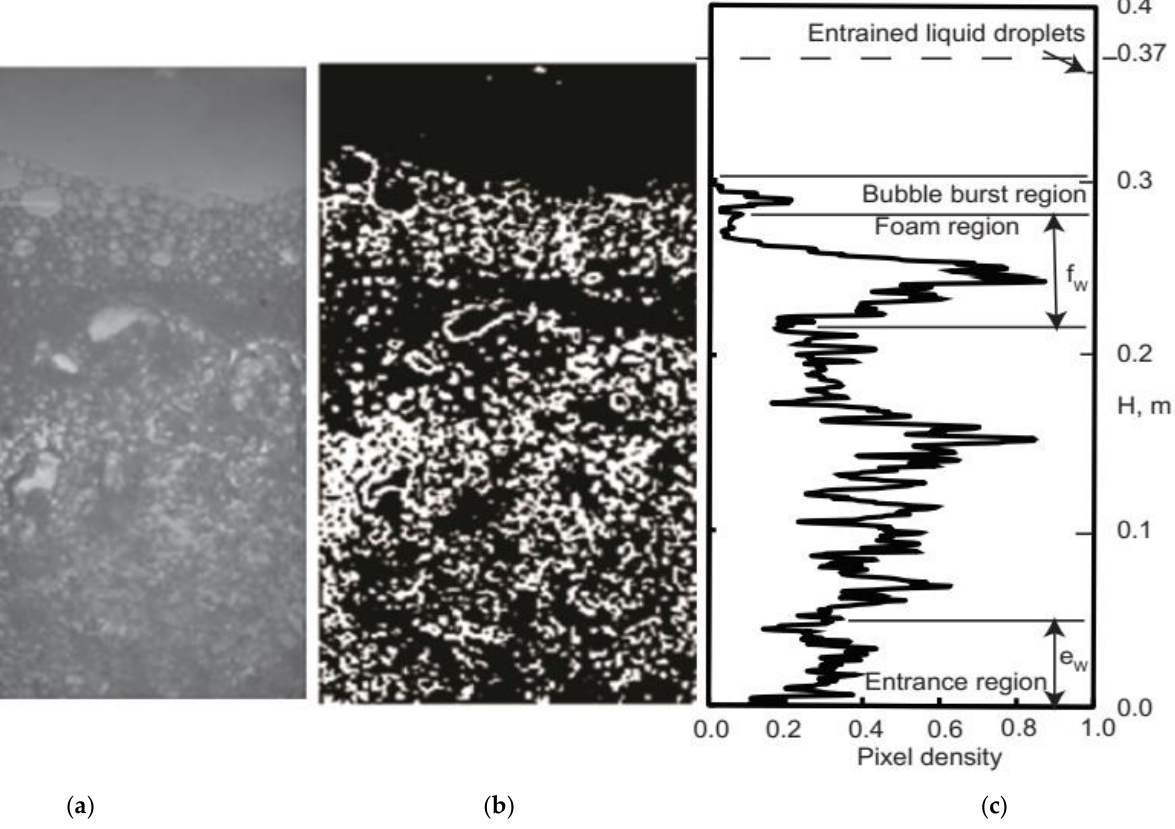
Figure 5. Image of gas – liquid dispersion in BC; ( a ) original image, ( b ) final bi-level image, ( c ) PI at different positions above the gas sparger.